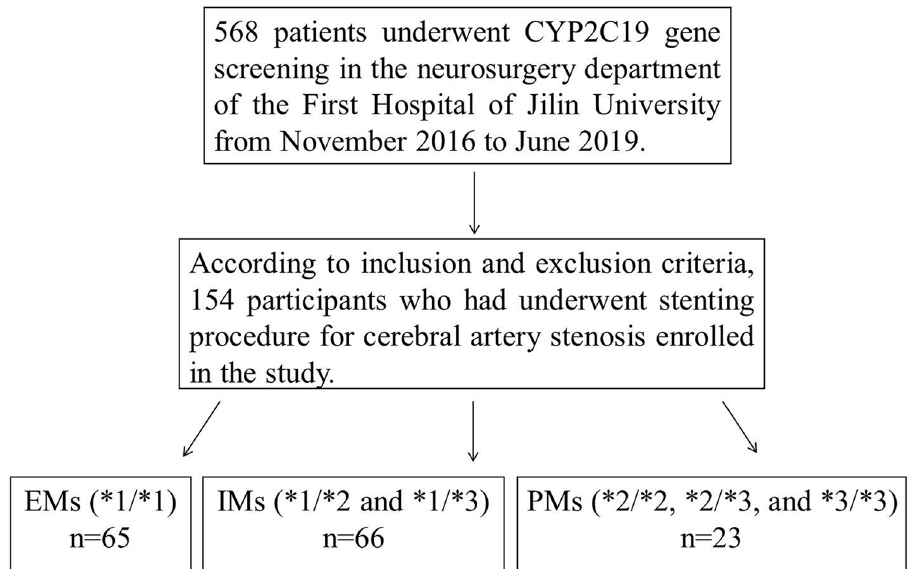
Figure 2. Patient screening and grouping. EMs, extensive metabolizers; IMs, intermediate metabolizers; PMs, poor